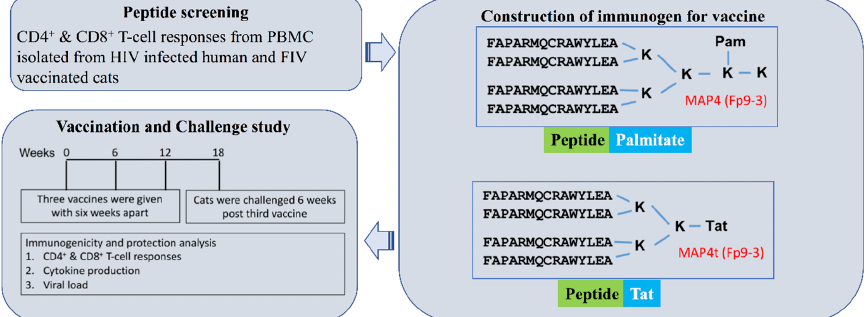
Figure 1. Schematic of the study: Evolutionarily or lentivirally conserved peptides were selected based upon their ability to induce CD8 + T-cell proliferation in isolated peripheral blood mononuclear cells (PBMC) of infected human HIV + patients and feline immunodeficiency virus (FIV) vaccinated cats. These selected peptides (shown in Table 1) were tagged at their carboxyl-end with palmitate or Tat peptide sequence for their sufficient intracellular delivery for enhancement of CD8 + T-cell responses.